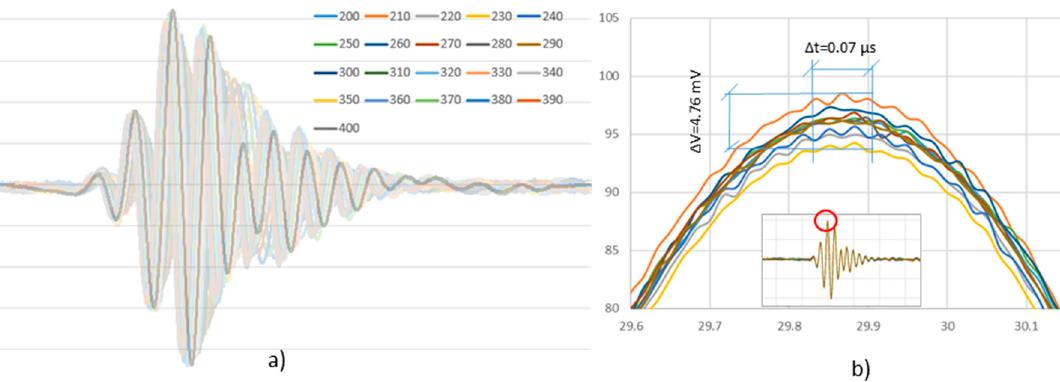
Figure 2. Results of the tests to determine: ( a ) the optimal frequency used in the UGWT, where the signal with the highest amplitude corresponds to the test at 340 kHz and it is highlighted; ( b ) the precision of the repeatability of the UGWT, and the focus is set on the peak of a cycle.